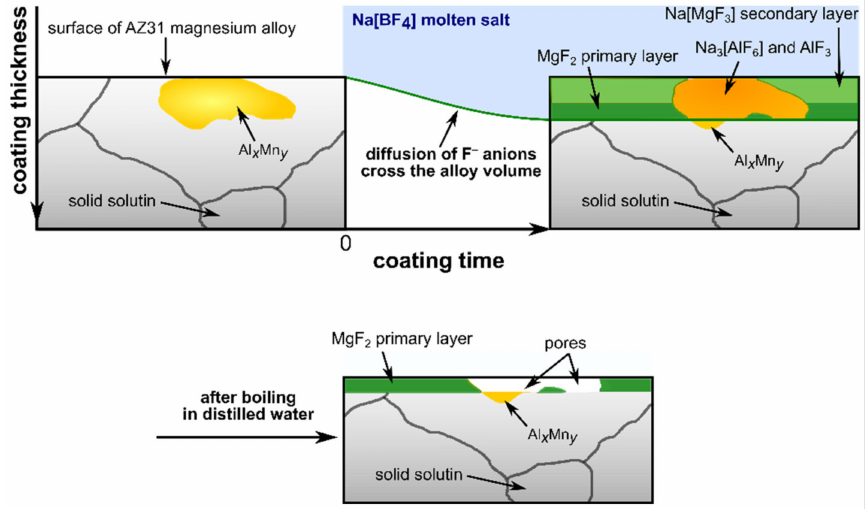
Figure 5. The probable mechanism of pores